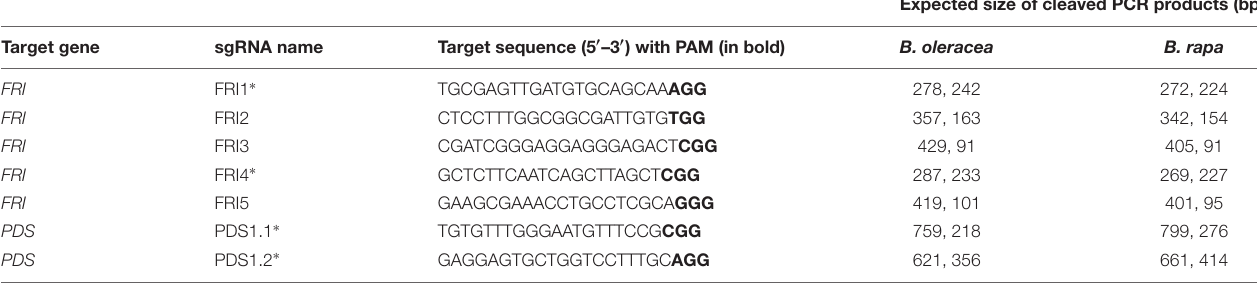
Expected size of cleaved PCR products (bp)